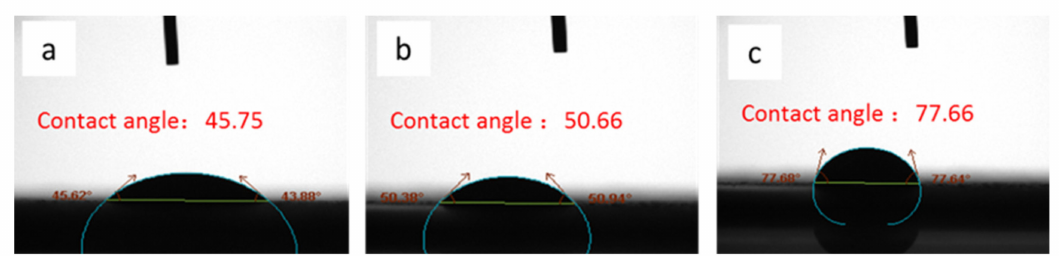
Figure 4. Dynamic contact angle test of bifunctional TiO 2 sheets with di ff erent mass ratio of CA and TiO 2 ( a ) 0.05:1; ( b ) 0.055:1; ( c )